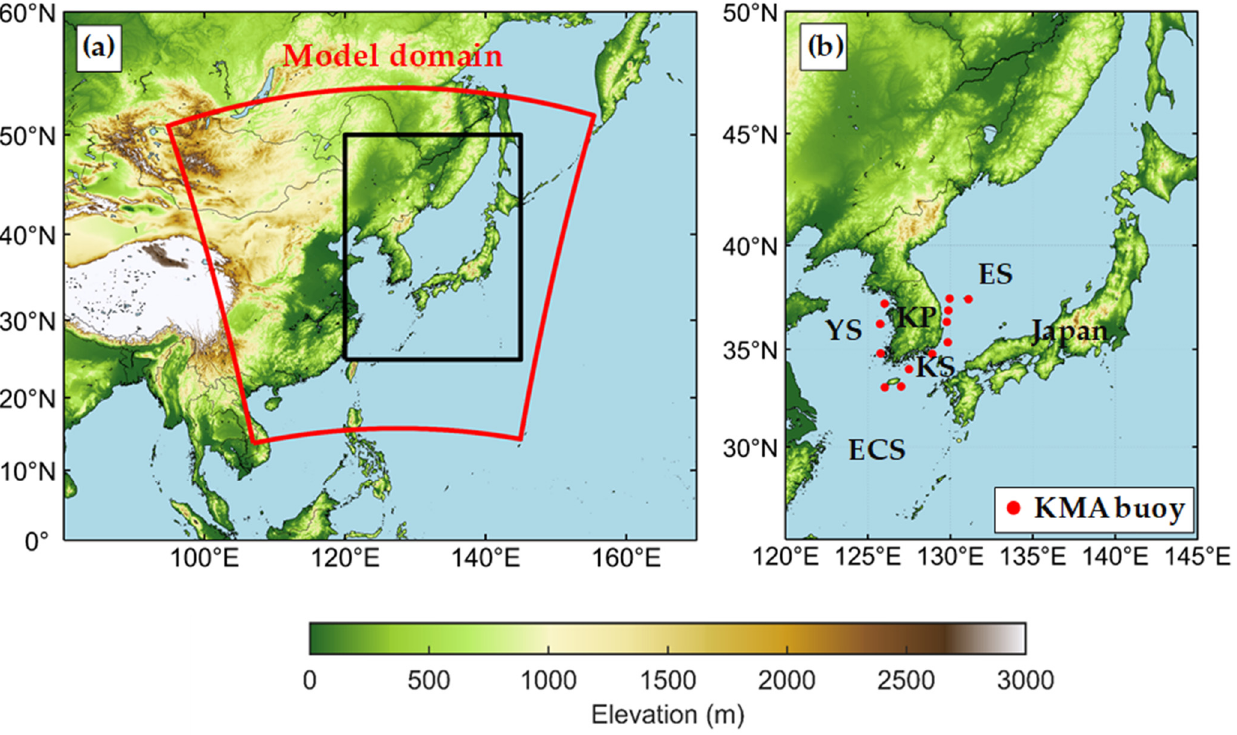
Figure 1. Orography of the WRF with the Advanced Research dynamical solver (WRF-ARW) domain. ( a ) Locations of model domain (red quadrangle) and study area (black rectangle). ( b ) Locations of buoys operated by the Korea Meteorological Administration. YS, KP, ES, ECS, and KS represent the Yellow Sea, Korean Peninsula, East Sea, East China Sea, and Korean Strait.